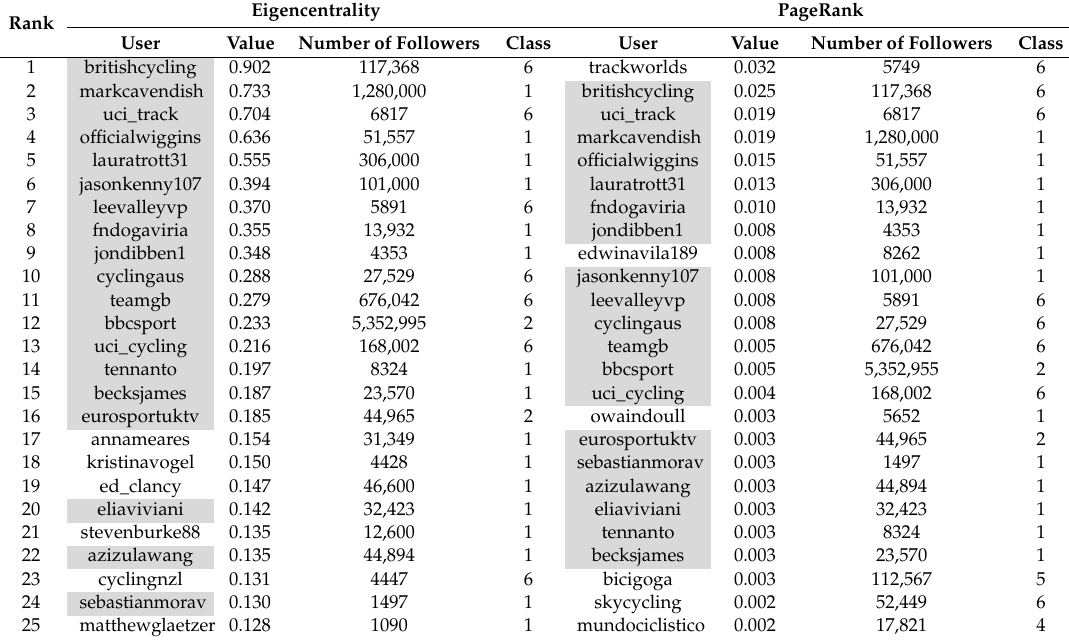
Table 5. Top 25 users by